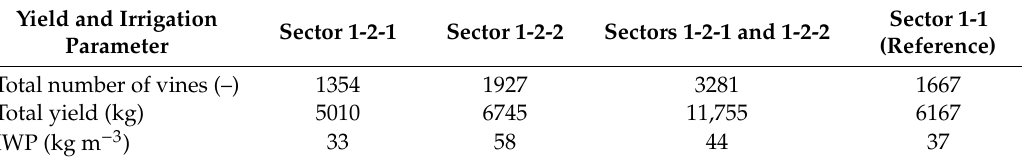
Table 8. Parameters used to calculate the irrigation water productivity (IWP) index; the total number of vines was estimated starting from the sector surface and the vines spacing (2.4 × 0.8 m), while total yield was obtained by multiplying the number of vines by the production per plant reported in Table